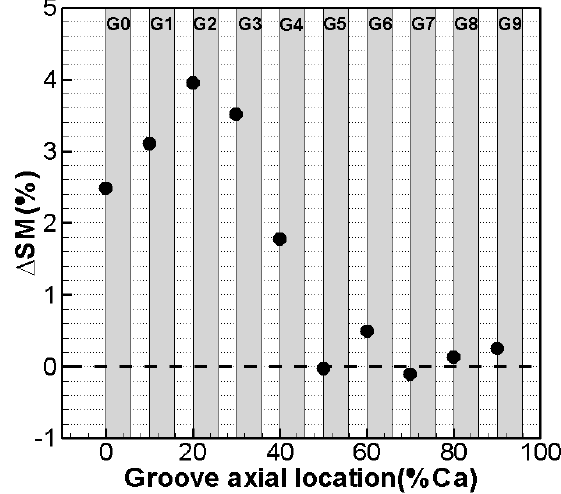
Figure 7. SMI trend as a function of groove location.